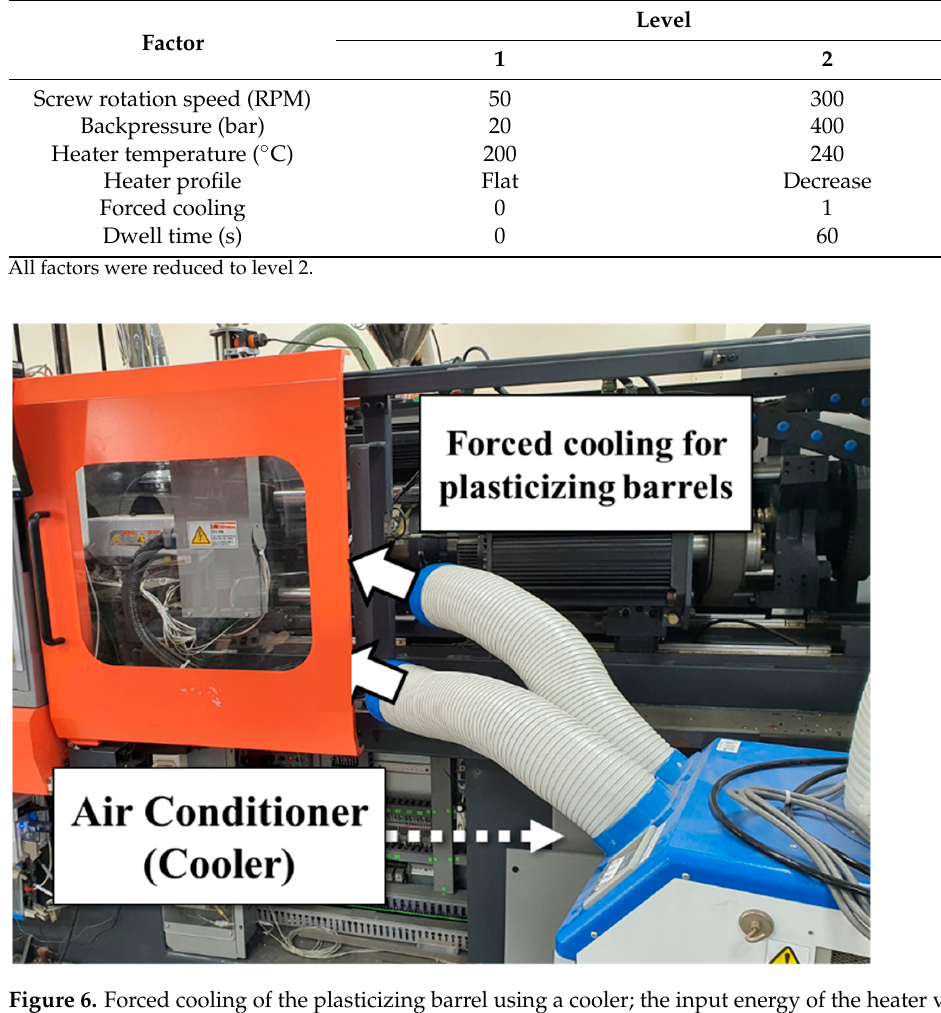
Table 2. Experimental conditions using ABS.